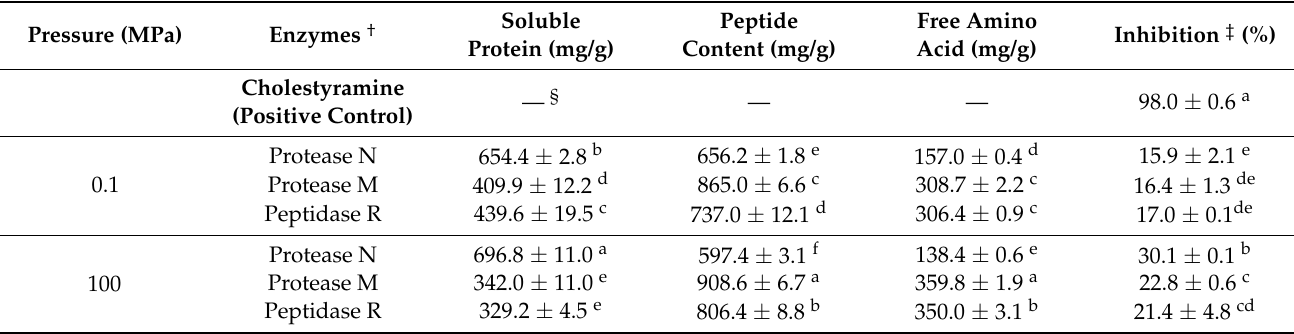
Table 1. Effect of proteases and HHP on chemical compositions and the inhibition against cholesterol micelle formation of seabass byproduct hydrolysates